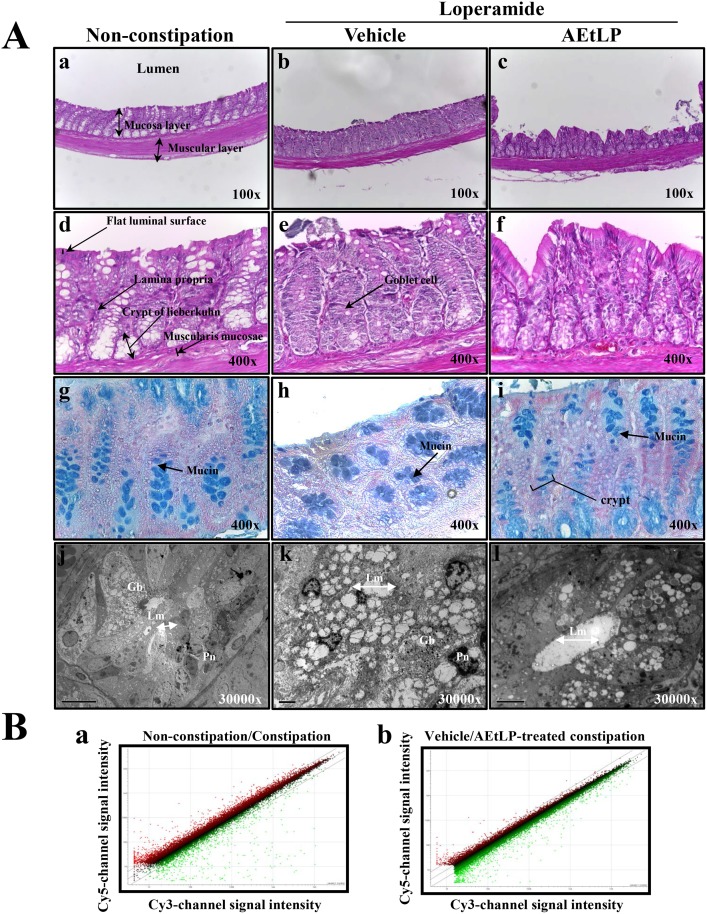
Effects of AEtLP on the histological parameters and global gene expression in loperamide-induced constipated rats.(A) H&E or Alcian blue-stained sections and ultra-thin sections of the distal colon in the non-constipation group (Aa, d, g and j), vehicle-treated constipation group (Ab, e, h and k), or AEtLP-treated constipation group (Ac, f, i and l) were observed by optical microscopy and TEM at the indicated magnifications. (B) Scatter plots. Each point represents the average expression for the same gene from the non-constipation/constipation group (Ba) and vehicle-/AEtLP-treated constipation group. (Bb) The Cy3-channel indicates the control sample and the Cy5-channel indicates the test sample. The Cy5-channel axis shows that the probe of the Cy5-channel (vehicle-treated constipation group or AEtLP-treated constipation group) shows a signal intensity more than two times higher than that of the Cy3-channel (non-constipation group or constipation group), whereas the Cy3-channel axis shows the reverse situation.